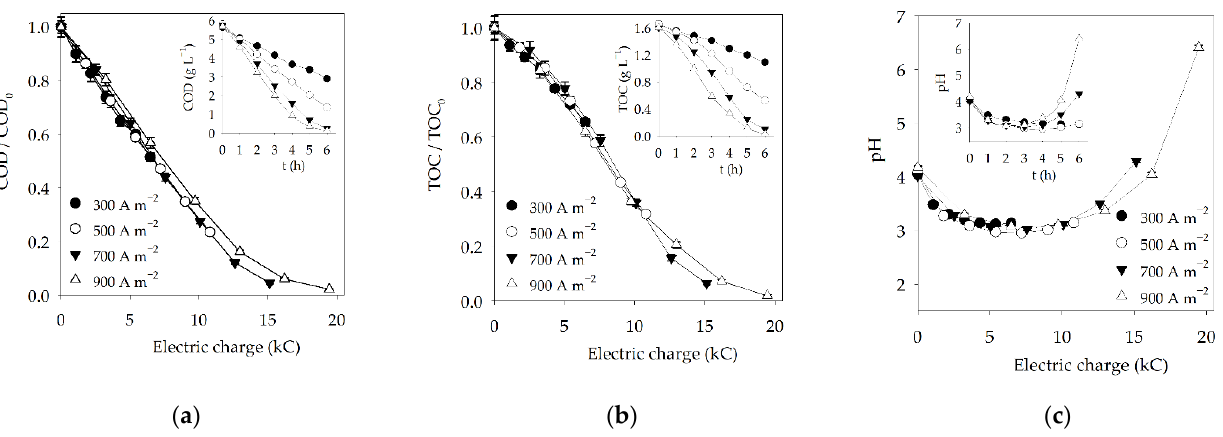
Figure 4. Variation with applied charge and with time (insets) of ( a ) COD, ( b ) TOC, and ( c ) pH for EO experiments performed with spiked winery wastewater at different applied current densities.